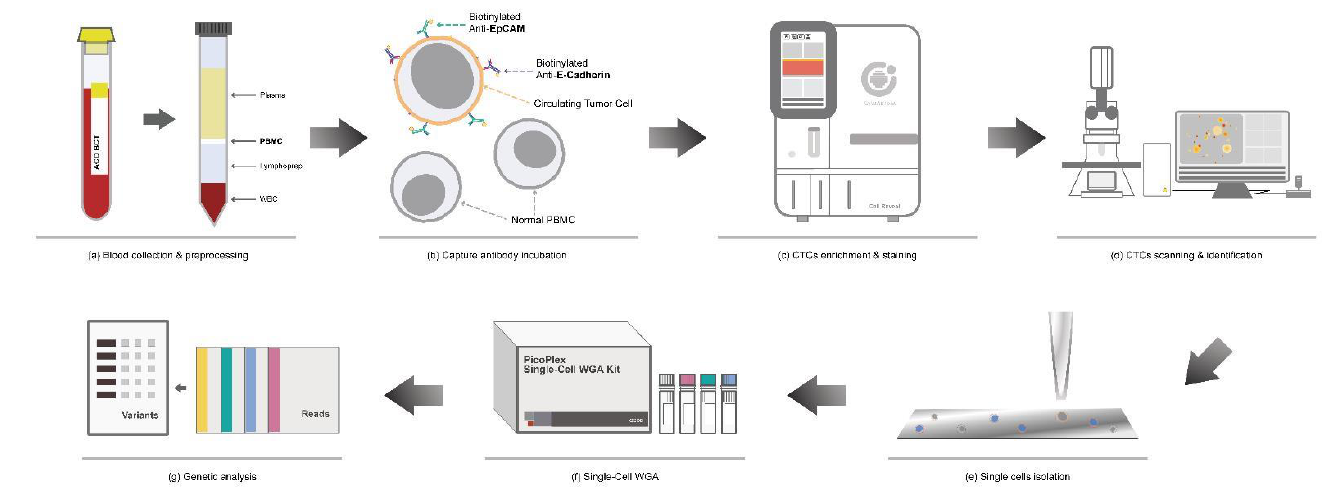
Figure 8. Schematic workflow of circulating tumor cell (CTC) enrichment and characterization. ( a ) Density gradient centrifugation was used to isolate peripheral blood mononuclear cells (PBMCs) from the blood sample. ( b ) PBMCs were incubated with biotinylated antibodies. ( c ) CTCs were enriched and stained via Cell Reveal TM . ( d ) The whole chip image was acquired via an automatic scanning system controlled by CytoAcqImages software. Cell Analysis Tools was used to identify the target cells, record their position, and document their morphology. ( e – g ) Using Cell Picker, high-purity single cells were isolated for whole genome amplification (WGA) and genomic analysis.